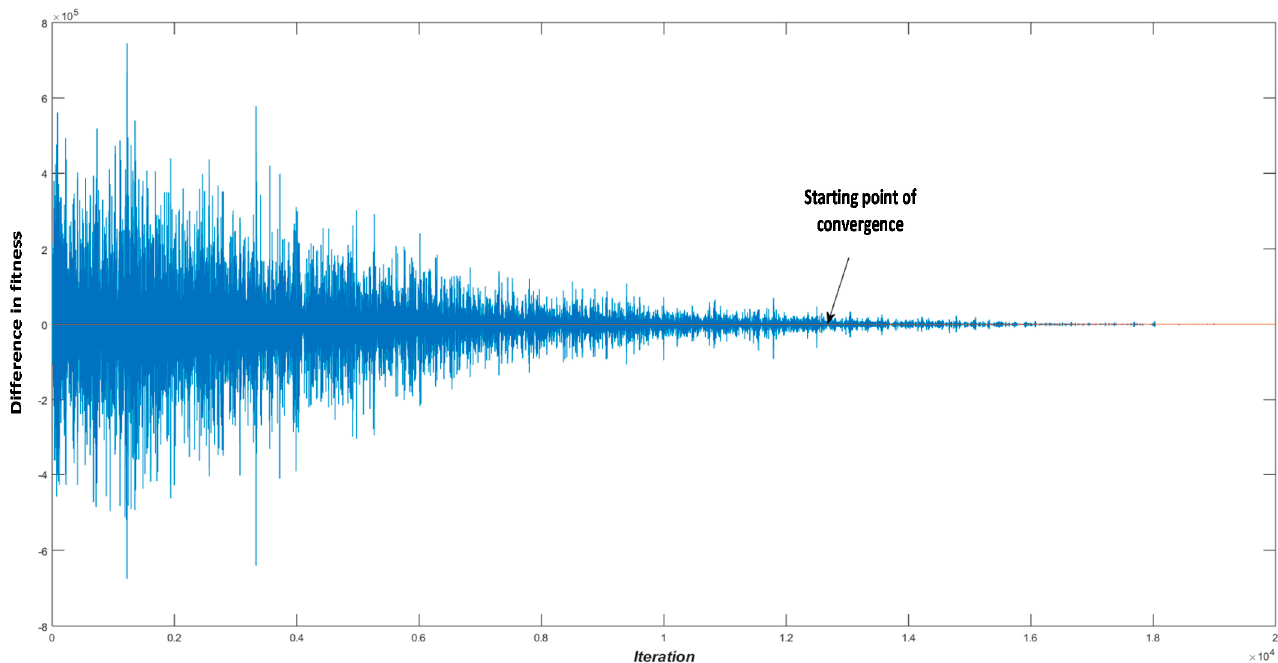
Figure 3. The convergence rate of the search mechanism.